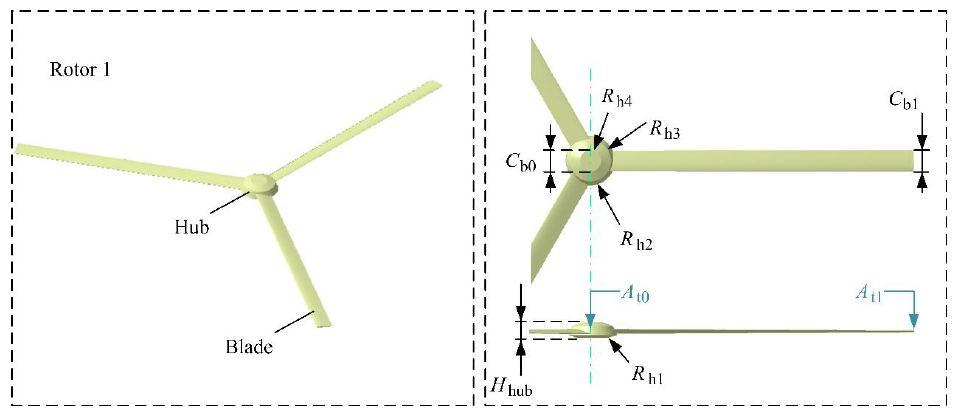
8 of 19 Figure 3. Tandem helicopter model and its size distribution. Table 1. The main dimensions of the helicopter model. Parameter